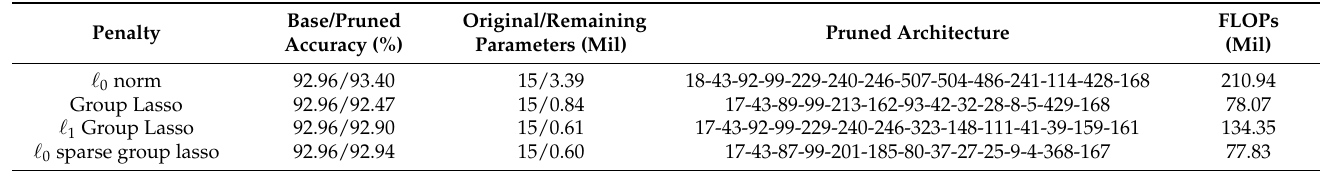
Table A4. Alation studies on